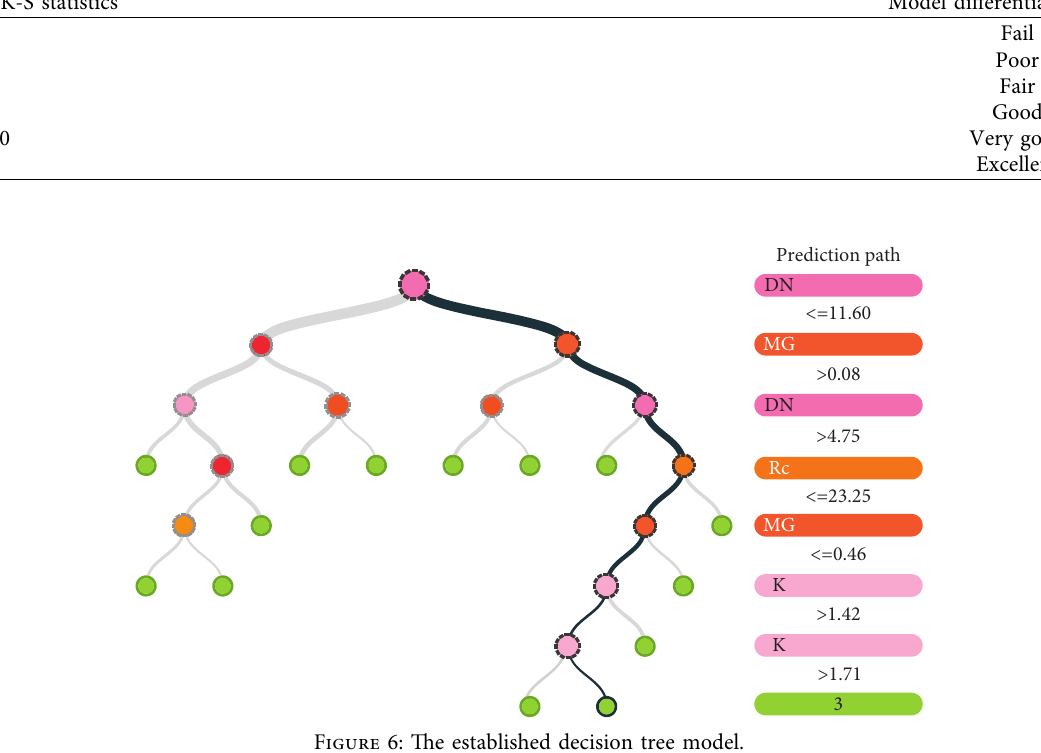
Figure 6: The established decision tree model.